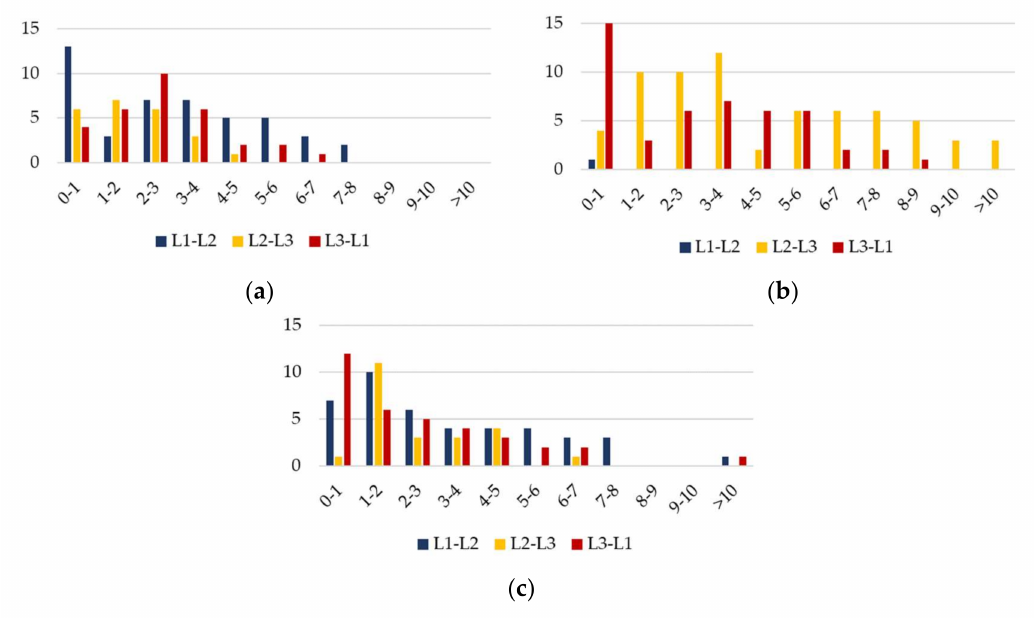
Figure 20. The number of hours in the year when the upper limit of the R15 bus voltage is exceeded within one of the defined ranges (V): ( a ) V3, ( b ) V5, and ( c )